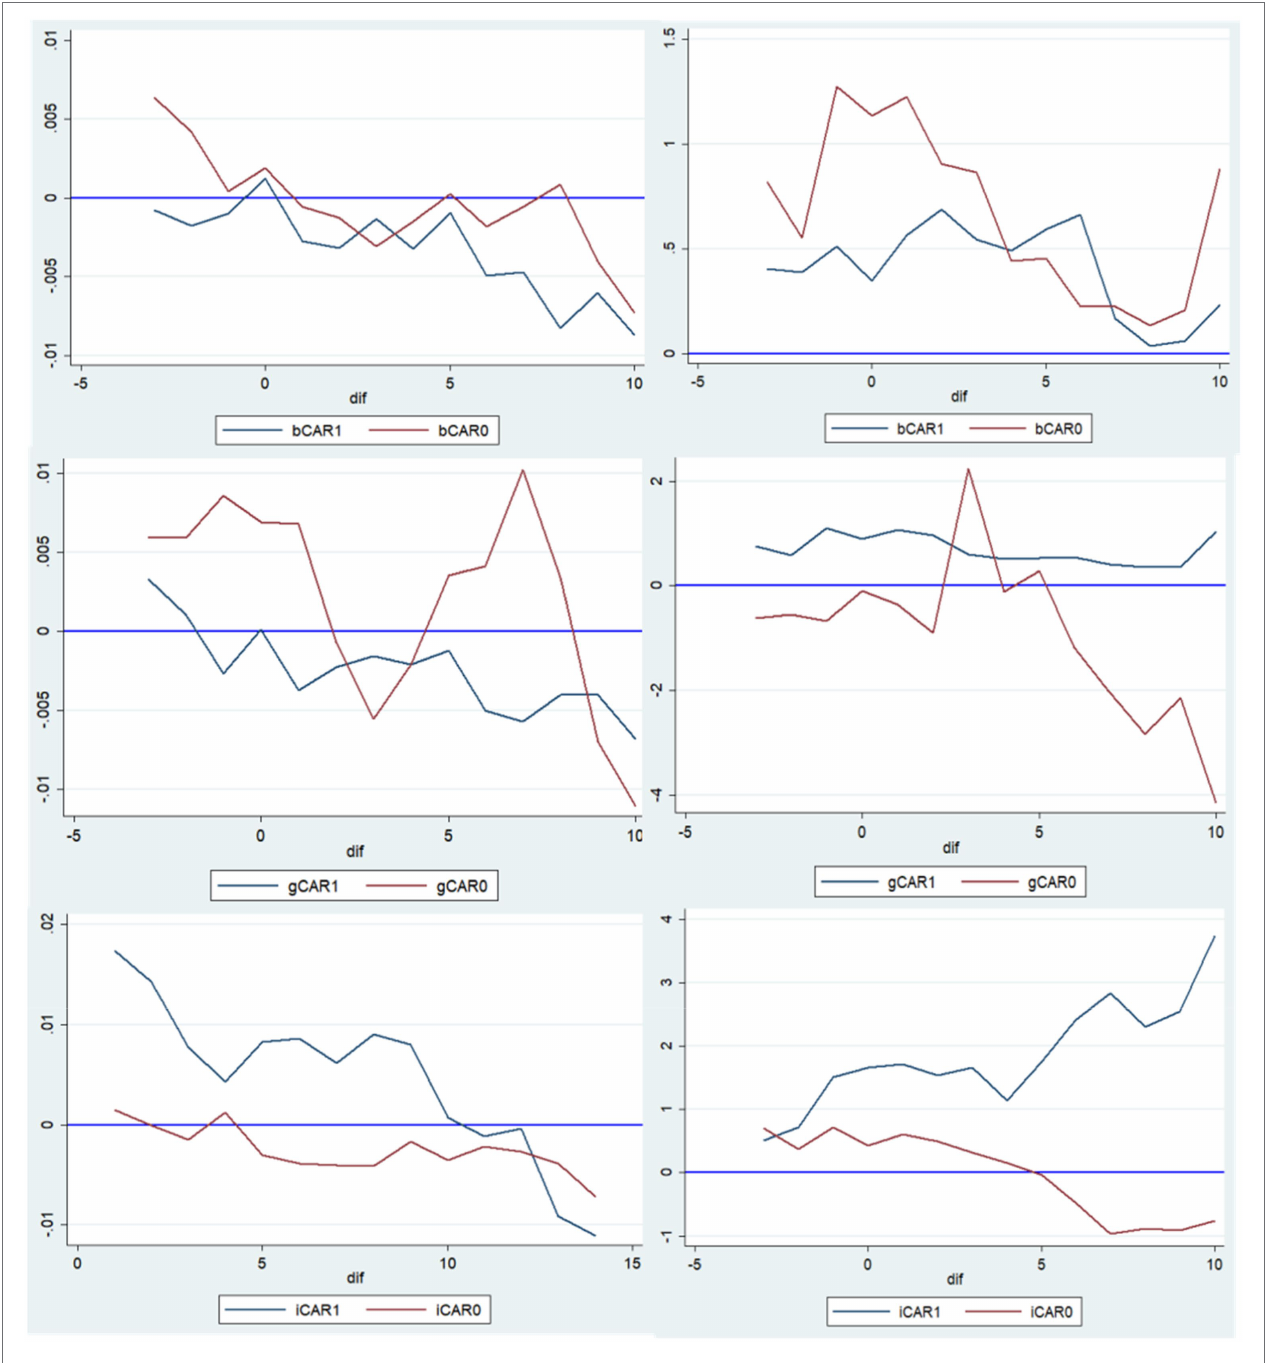
FIGURE 3 | Comparison of CAR in two stock markets (Left: Mainland China, Right: Hong